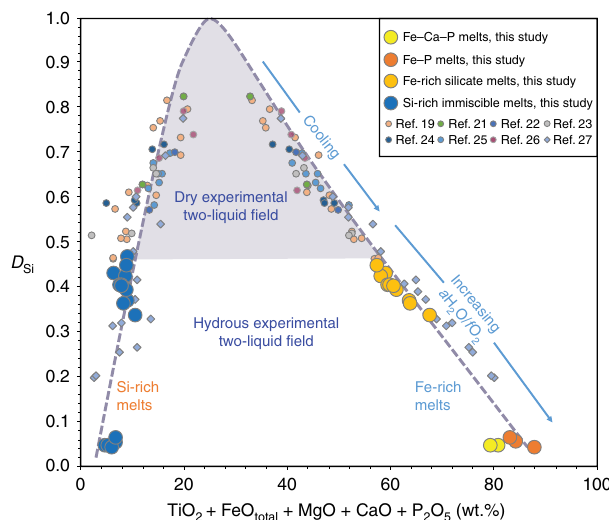
Fig. 4 Compositions of conjugate immiscible melts in this study compared to previous experimental melt pairs in tholeiitic systems 19, 21 – 26 and native iron-hosted melt inclusions in lavas of the Siberian Traps 27 . D Si , the partitioning of SiO 2 between the Fe-rich and Si-rich melts, expresses the compositional gap between the two melts, plotted as a function of elements partitioned into the Fe-rich